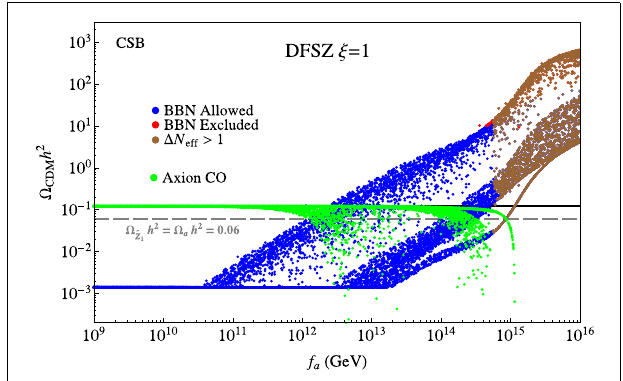
FIGURE 5 | The wino-like WIMP and axion relic densities from a scan over SUSY DFSZ parameter space for the CSB benchmark case with ξ = 1 . The gray dashed line shows the points where DM consists of 50% axions and 50% neutralinos.